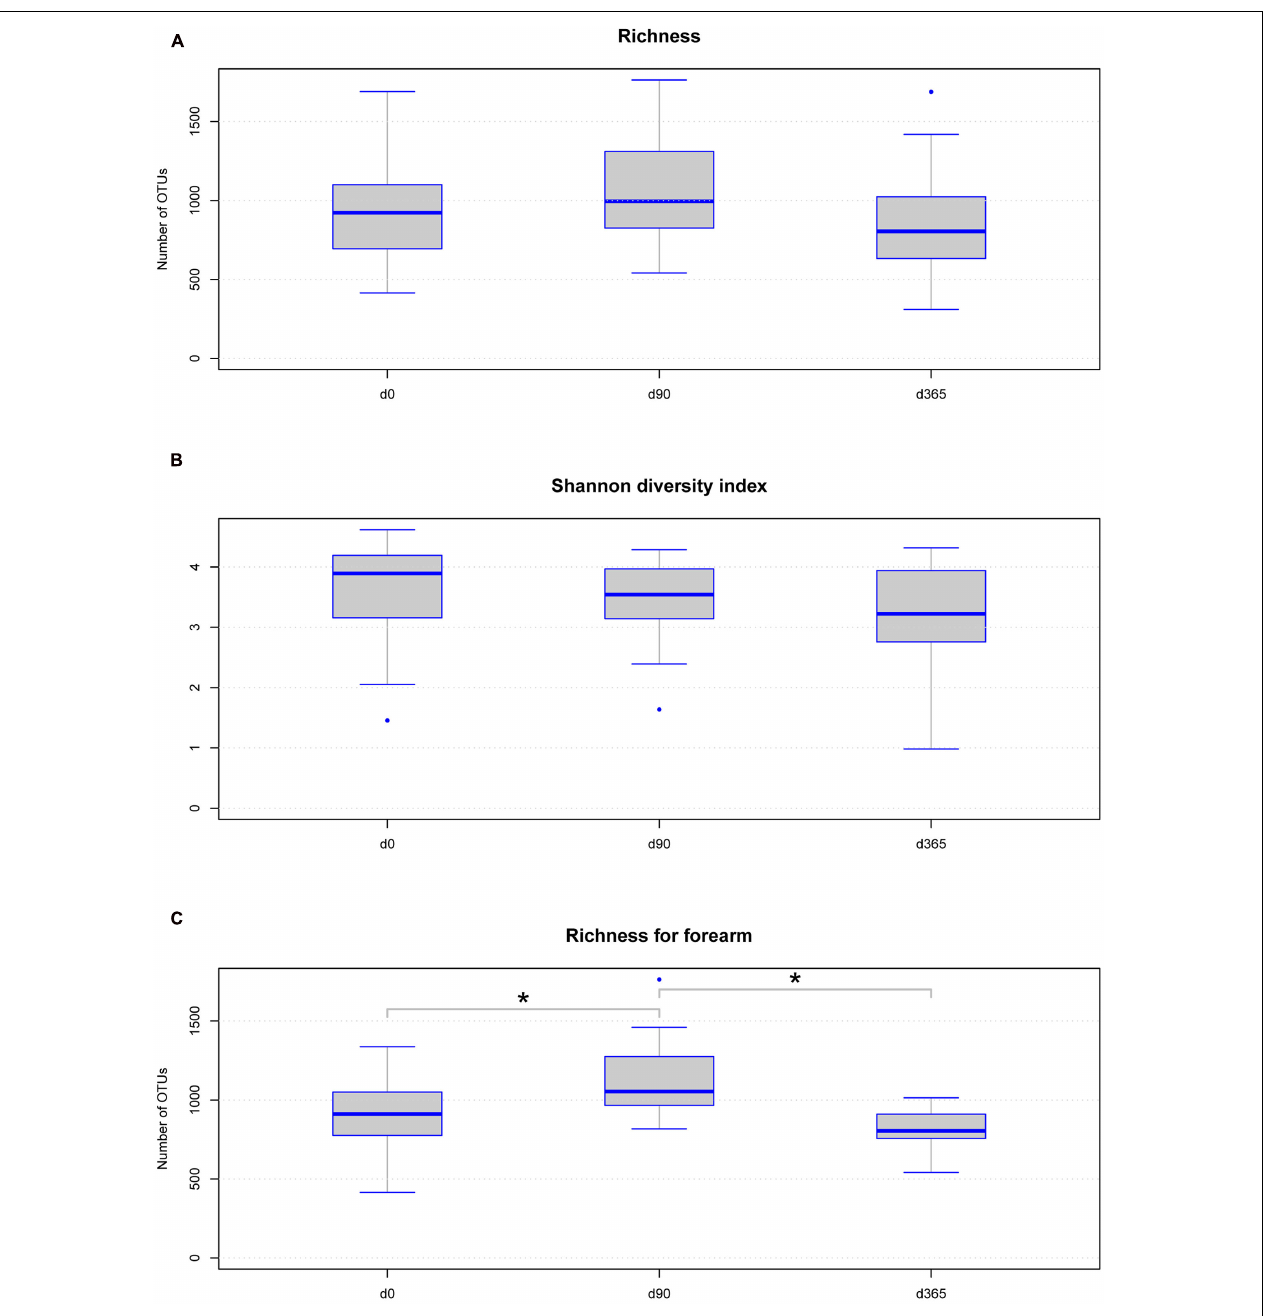
FIGURE 3 | Boxplot diagram for skin microbial richness (A) and Shannon diversity index (B) over all body locations according to sample storage duration: neither richness nor Shannon diversity index is significantly changed among the storage groups. The trend on increased richness at d90 in all samples is not statistically significant. Only the change in forearm sample richness between d0 and d90 ( p -value = 0.0234) and d90 and d365 ( p -value = 0.0234) is statistically significant (C) , but no difference is observed between d0 and d365 using Wilcoxon test. Significant differences ( p -value below 0.05) are marked with a line between the affected sample groups and an